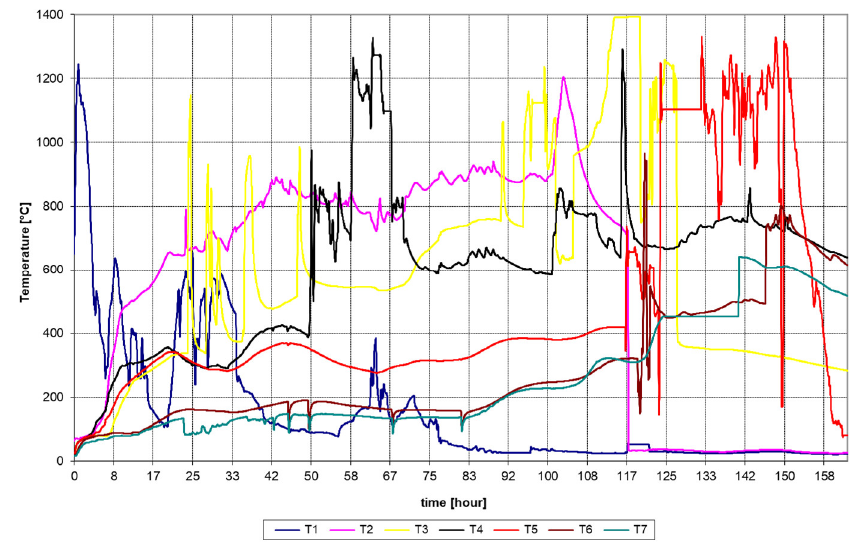
Figure 7. Temperature course in the gasification channel during the first experiment.